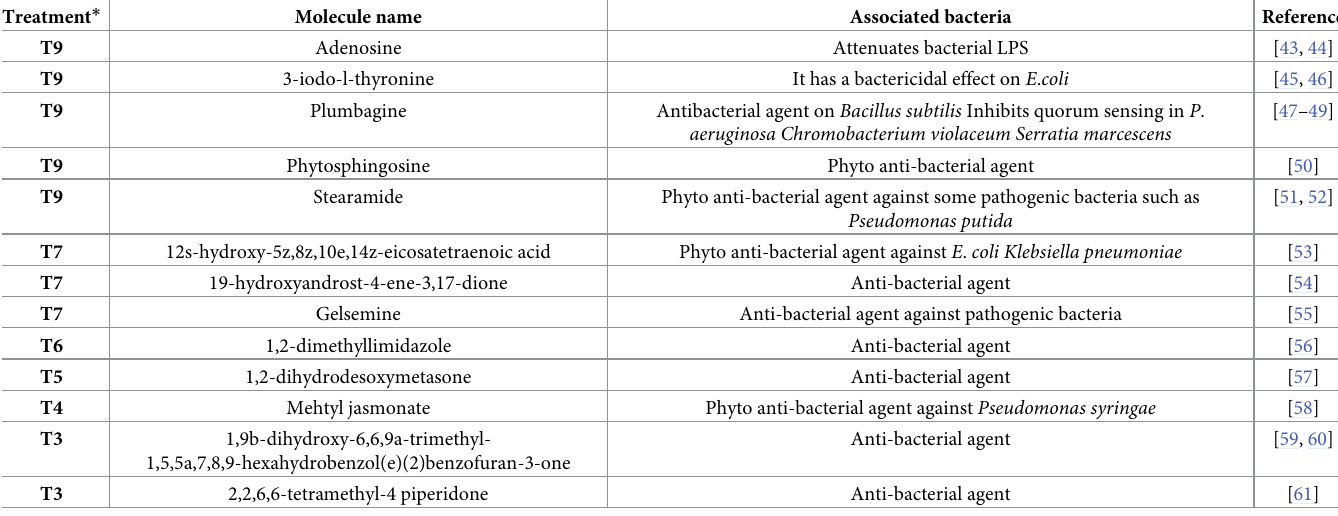
Table 2. Biofloc derived molecules as bacterial activity inhibitors.